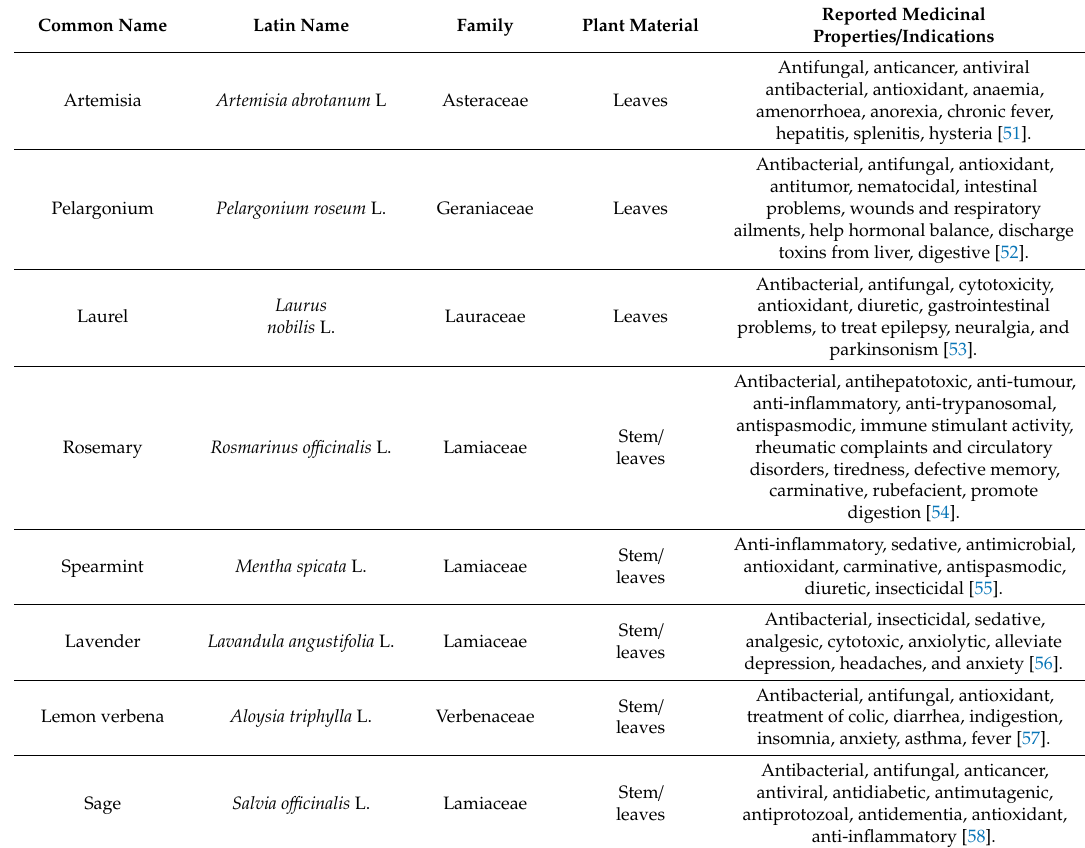
Table 1. Plant species and material